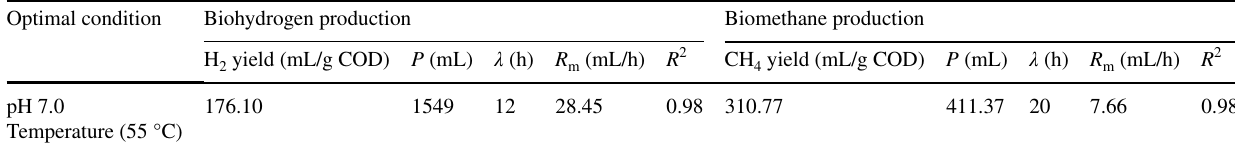
Table 1 Experimental kinetic parameters of biogas production from food waste in two-stage fermentation process Optimal condition Biohydrogen production Biomethane